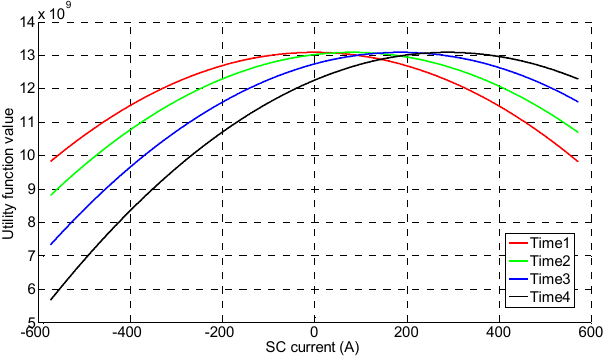
Figure 9. The utility functions of the SC in the first four seconds of lifting a container.